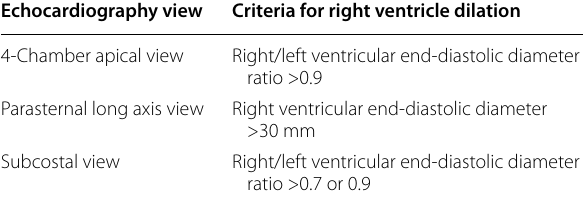
For the evaluation of the dimension of the right ventricle the preferred view should be the apical 4-chamber. The other views should be used as second choice in case of doubtful measure or impossibility to obtain a clear image